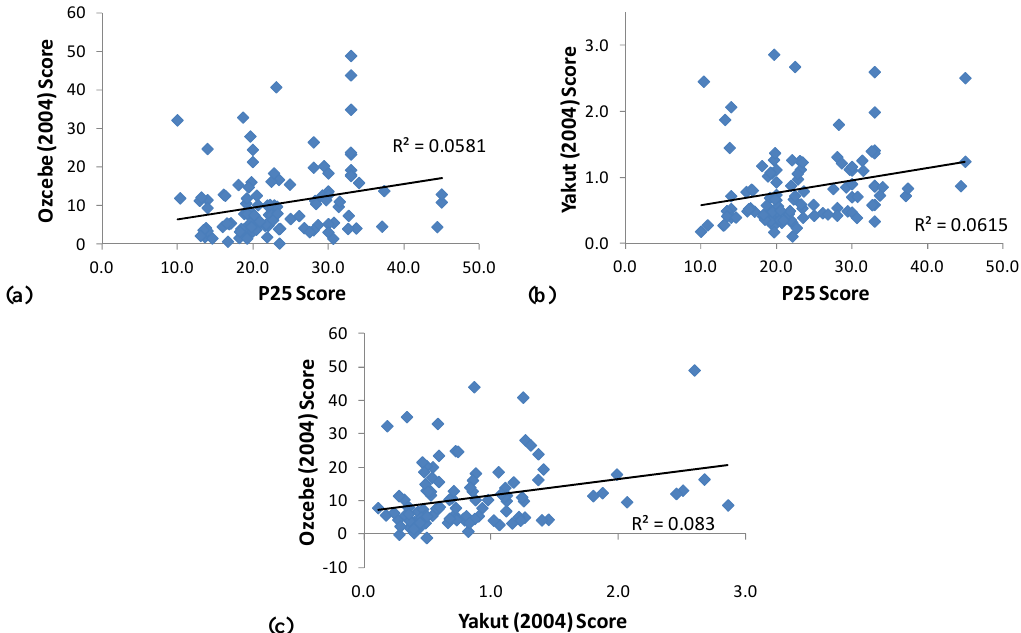
Fig. 3. Relation between the considered rapid evaluation methods: (a) P25 and Ozcebe (2004), (b) P25 and Yakut (2004), and (c) Yakut (2004) and Ozcebe Figure 3. Relation between the considered rapid evaluation methods: (a) P25 and Ozcebe 3 Figure 3. Relation between the considered rapid evaluation methods: (a) P25 and Ozcebe 3 Figure 3. Relation between the considered rapid evaluation methods: (a) P25 and Ozcebe 3 (2004) (b) P25 and Yakut (2004) (c) Yakut (2004) and Ozcebe (2004). 4 (2004) (b) P25 and Yakut (2004) (c) Yakut (2004) and Ozcebe (2004). 4 (2004) (b) P25 and Yakut (2004) (c) Yakut (2004) and Ozcebe (2004). 4